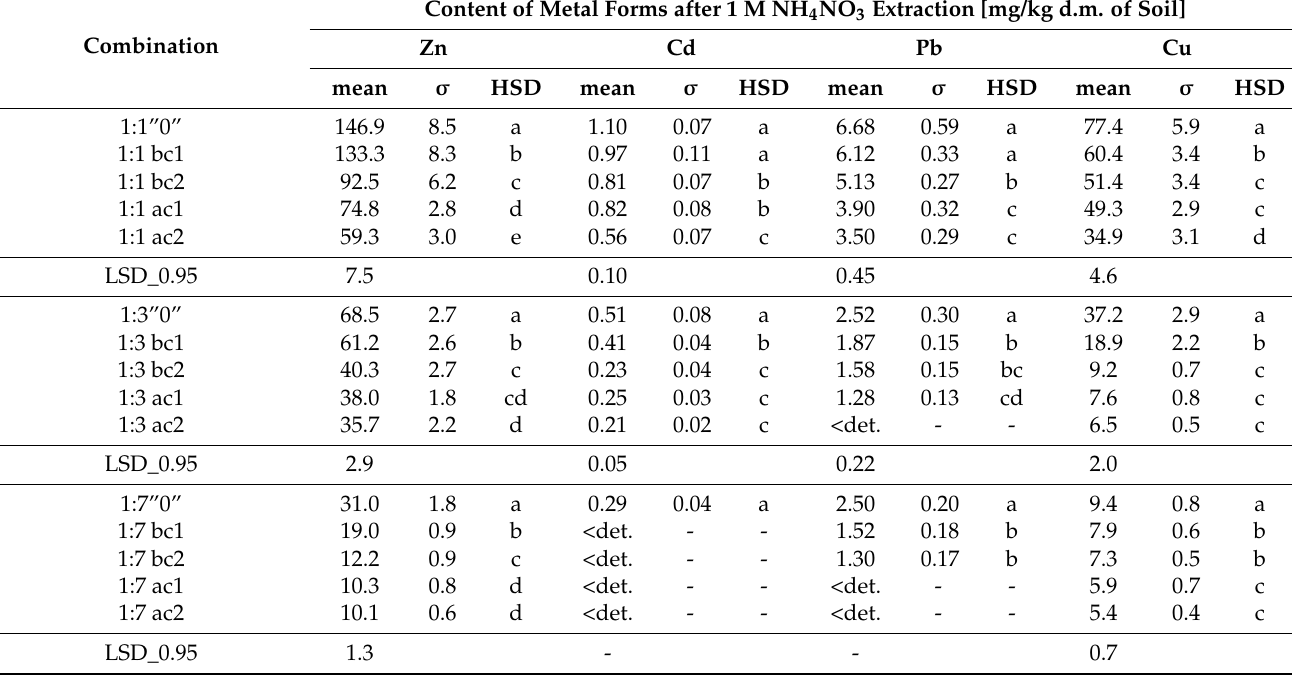
Table 7. Content of metal forms after 1 M NH 4 NO 3 extraction, depending on the dose of brown coal and activated carbon.